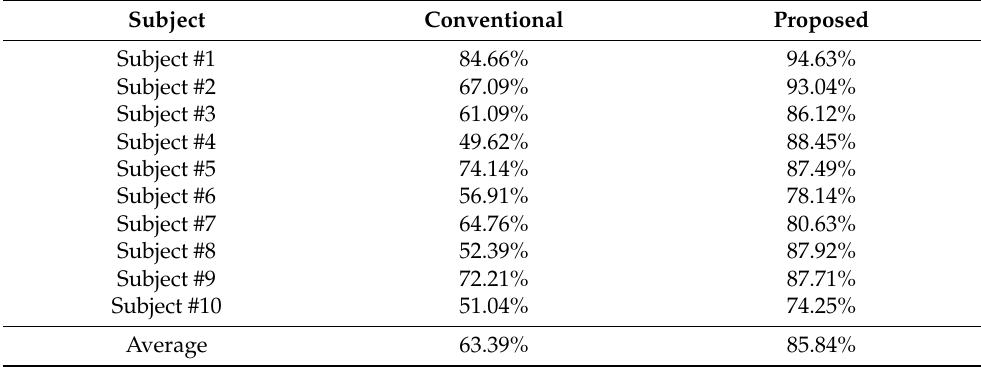
Table 5. Comparison of respiratory rate accuracy for the case shown in Figure